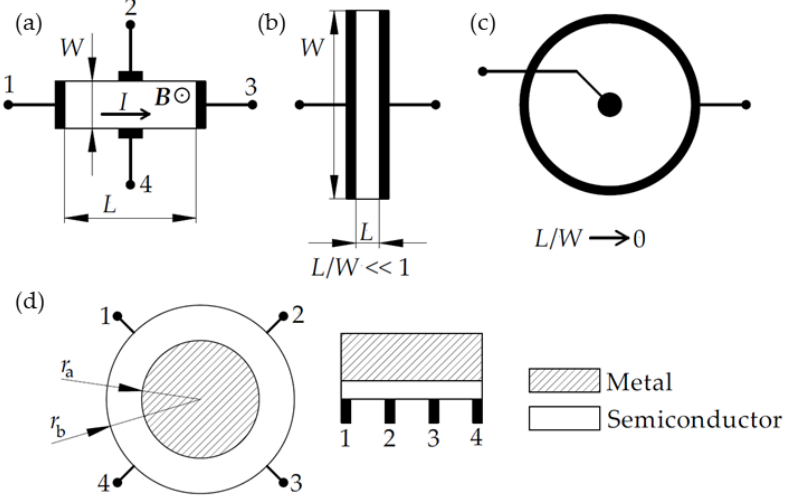
Figure 2. Main simplified configurations used for high-field magnetic sensors: ( a ) Hall-effect; ( b ) mag- netoresistance; ( c ) Corbino disc; and ( d ) extraordinary magnetoresistance: van der Pauw disc geome- try ( left ), bar shunt geometry ( right